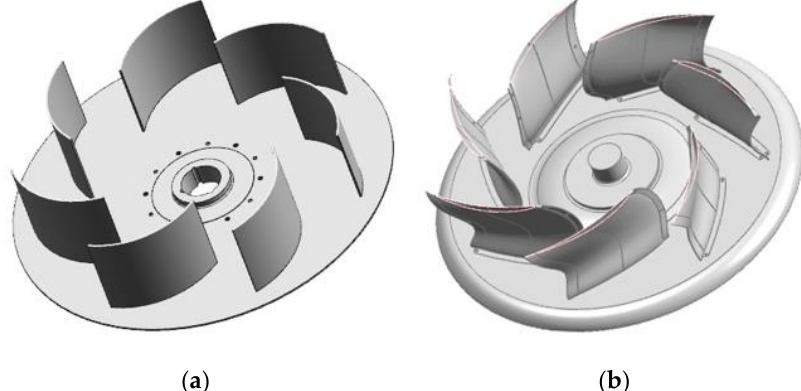
Figure 10. Geometric shape of the blades of the original and optimized models: ( a ) Original model;( b ) Optimized model.